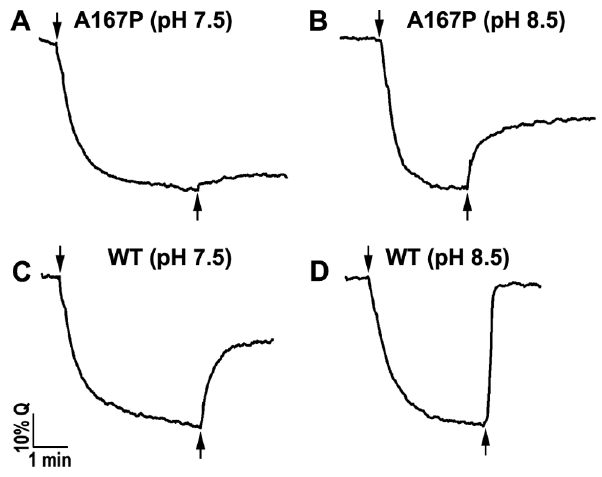
Figure 2. Na + /H + antiporter activity of variant A167P in isolated everted membrane vesicles. For measurement of the Na + /H + antiporter activity at the indicated pHs, E. coli EP432/A167P cells expressing variant A167P (A and B) or the wild type (C and D) were grown in LBK (pH 7.0) and everted membrane vesicles were isolated. The D pH across the membranes was determined using acridine orange, a fluorescence probe of D pH. The reaction mixture (2.5 ml) contained 50–100 m g of membrane protein, 0.5 m M acridine orange, 150 mM KCl, 50 mM BTP buffer, 5 mM MgCl 2 and the pH was titrated with HCl. The data of typical experiments are shown. At the onset of the reaction, D- lactate (2 mM) was added (downward facing arrow) and the fluorescence quenching ( Q ) was recorded until a steady-state level of D pH (100% quenching) was reached. NaCl (10 mM) was then added (upward facing arrow), and the new steady state of fluorescence obtained (dequenching) was monitored. Fluorescence dequenching indicated that protons are exiting the vesicles in response to Na + influx via the antiporter. All experiments were repeated at least three times with practically identical